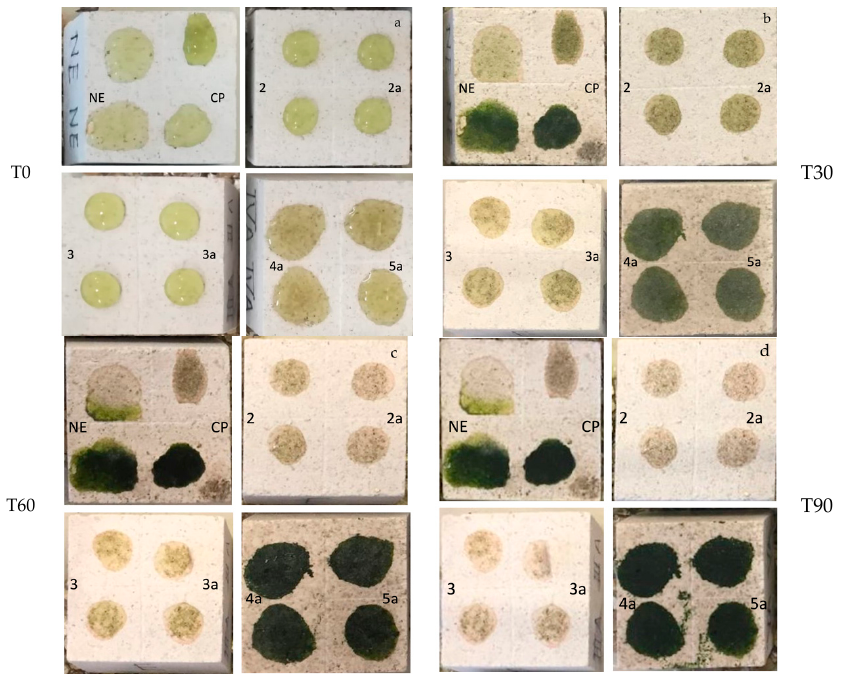
Figure 3. Untreated and treated tufa probes’ behavior toward the microbial colonization under laboratory conditions. ( a ) Immediately after inoculation, T0; ( b ) after 30 days of incubation under constant illumination, T30; ( c ) after 60 days of incubation under constant illumination, T60; and ( d ) at the end of experimentation (90 days of incubation under constant illumination), T90. After 30 days of incubation, a good establishment of biofilm in the controls (both untreated and treated with NanoEstel) was observed with some differences in color in- tensity (Figure 3b). A homogeneous more intense greenish color of the biofilm was ob- served on the samples coated with 4a and 5a , while on those treated with 2 , 2a , 3 and 3a the biofilm turned a yellow color.